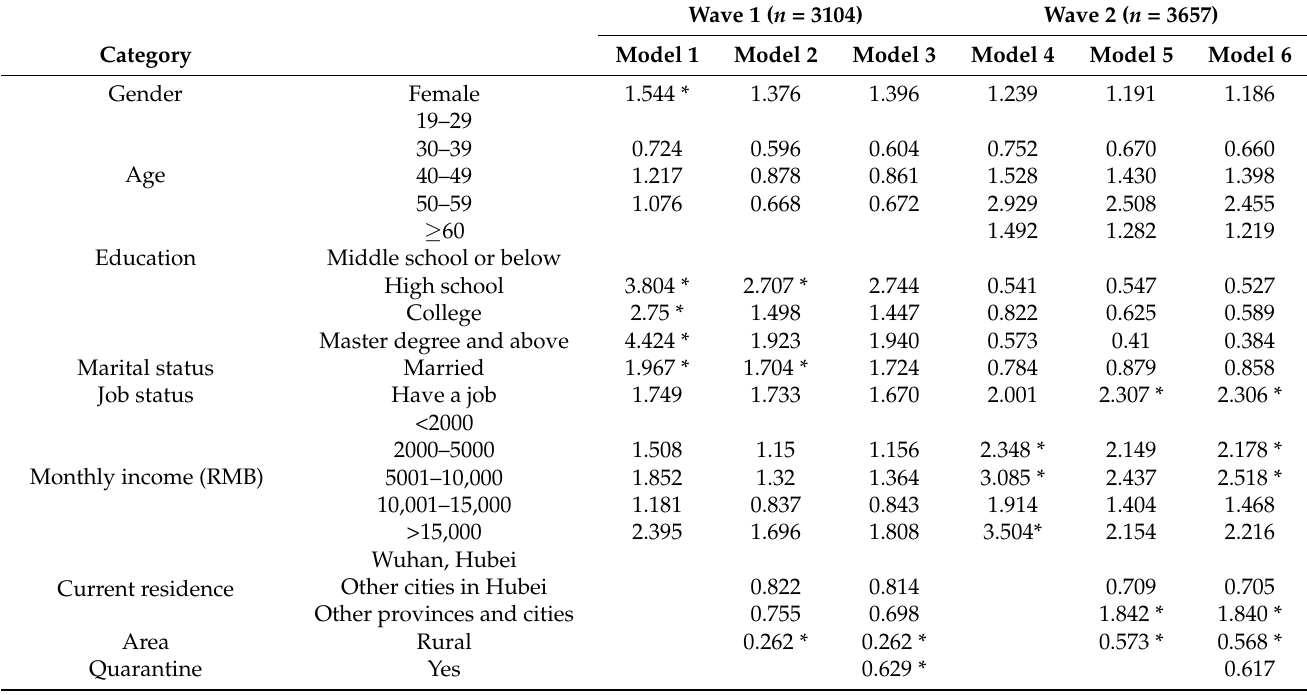
Table 3. Multivariable logistics regression of participants’ wearing a mask ( n =